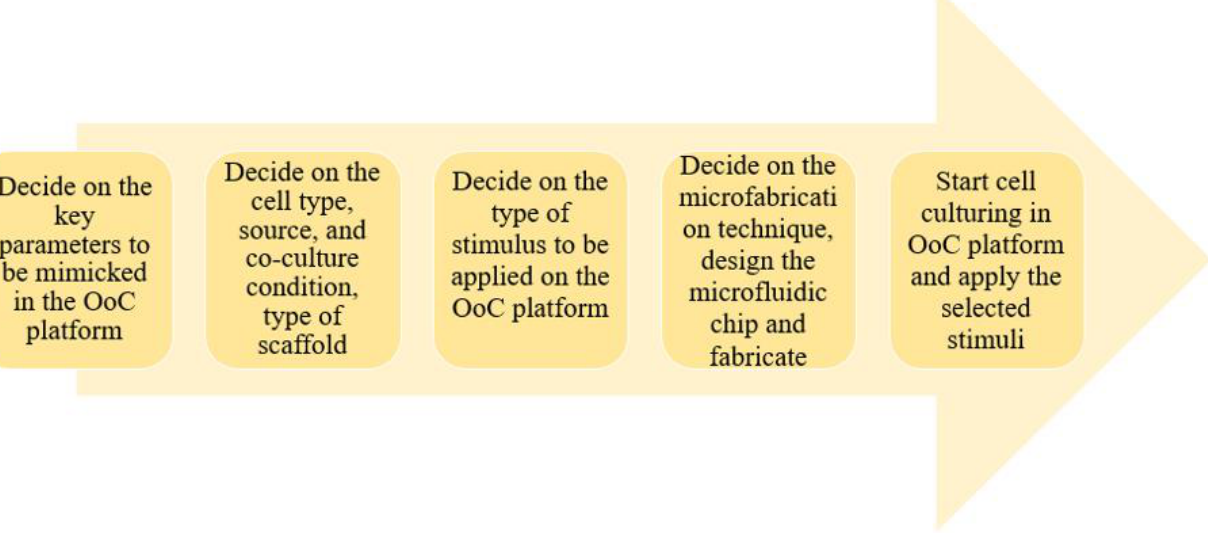
Figure 1. Typical prototyping steps followed to fabricate a microfluidic OoC